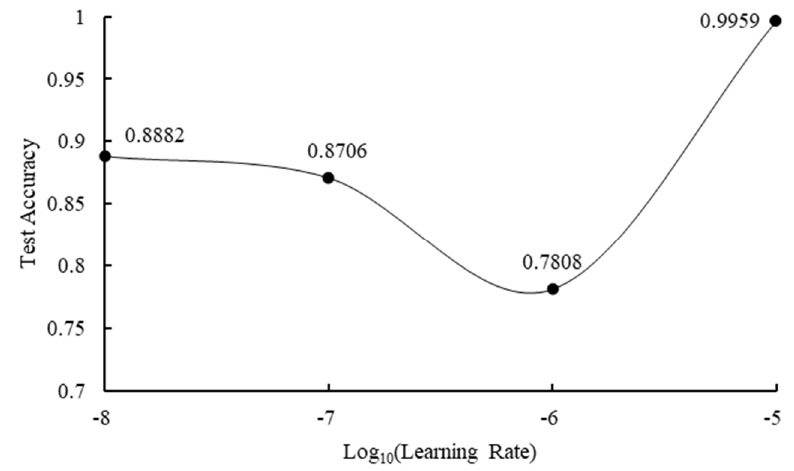
Figure 8. The relationship between test accuracy and learning rate.